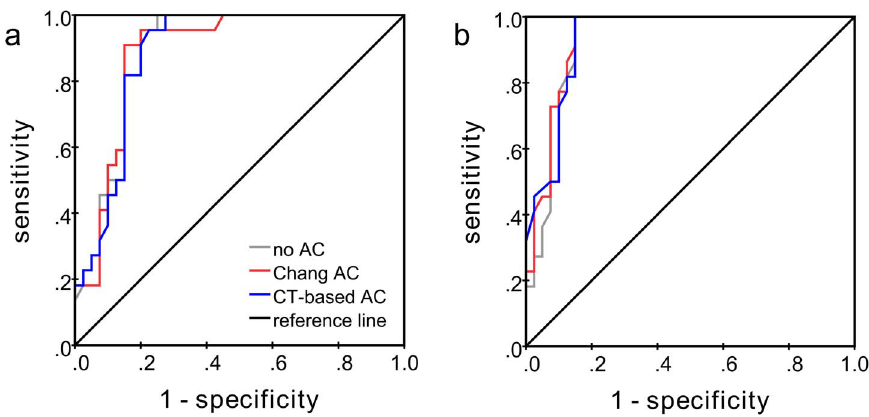
Figure 4. ROC curves for the differentiation between reduced and normal DAT availability by the SBR of the caudate (a) and the putamen (b) (minimum over both hemispheres).